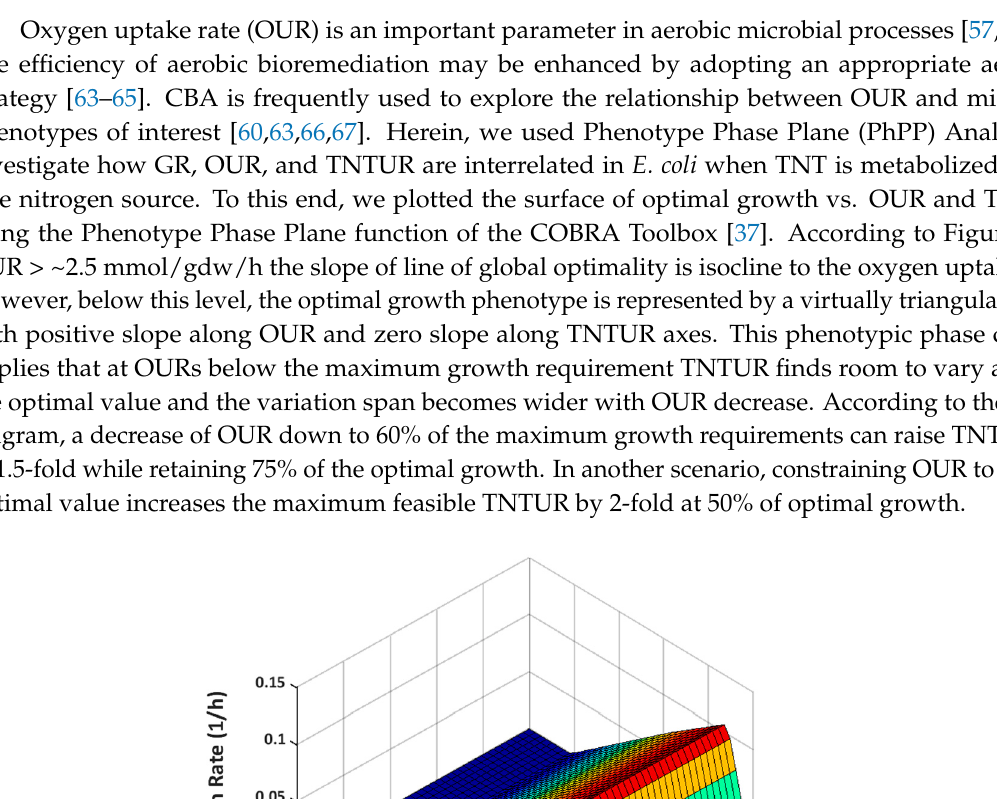
Figure 8. TNT Uptake Rate (TNTUR) as a function of oxygen uptake rate (OUR) relative to the optimal value (%). As mentioned earlier, the low aeration regime, while possibly enhancing biotransformation rate, may negatively impact the productivity due to reduced GR. To examine whether the low-OUR- induced improvement in TNTUR would be followed by productivity, using DFBA we computed the